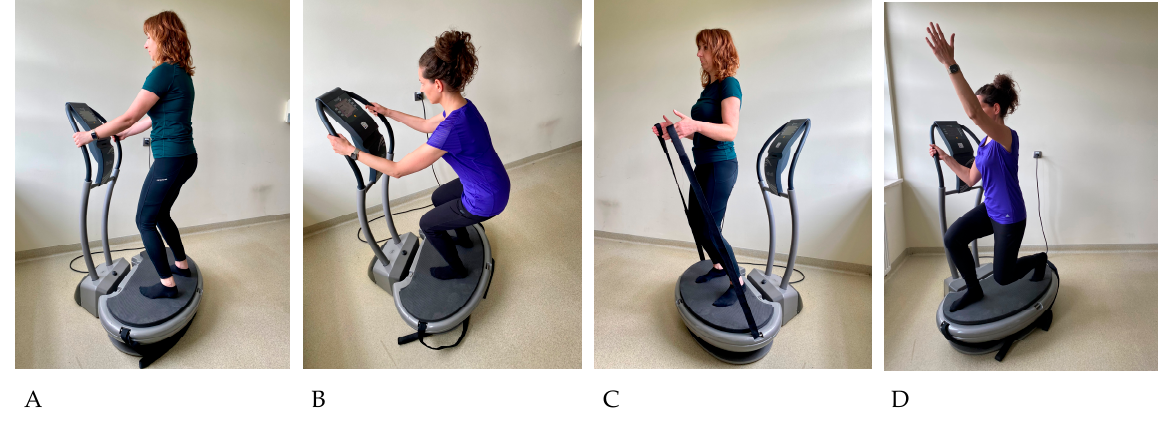
Figure 2. Exercises performed in the main part of the training session on a vibrating platform. ( A ) Front standing position on the platform with a two-handed safety grip on the platform railings (exercise no. 1); ( B ) Dynamic squat (exercise no. 2) and static squat (exercise no. 6) to the angle of 90° in the knee joints; ( C ) Back standing position on the platform while holding the tapes in the hands (exercise no. 3) in the closed biokinetic chain for the upper and lower extremities’; ( D ) Dynamic squat in a lunge with a one-handed safety grip and raising the opposite upper limb—exercise performed twice, once with the right and once with the left lower limb (exercise no. 4 and 5).